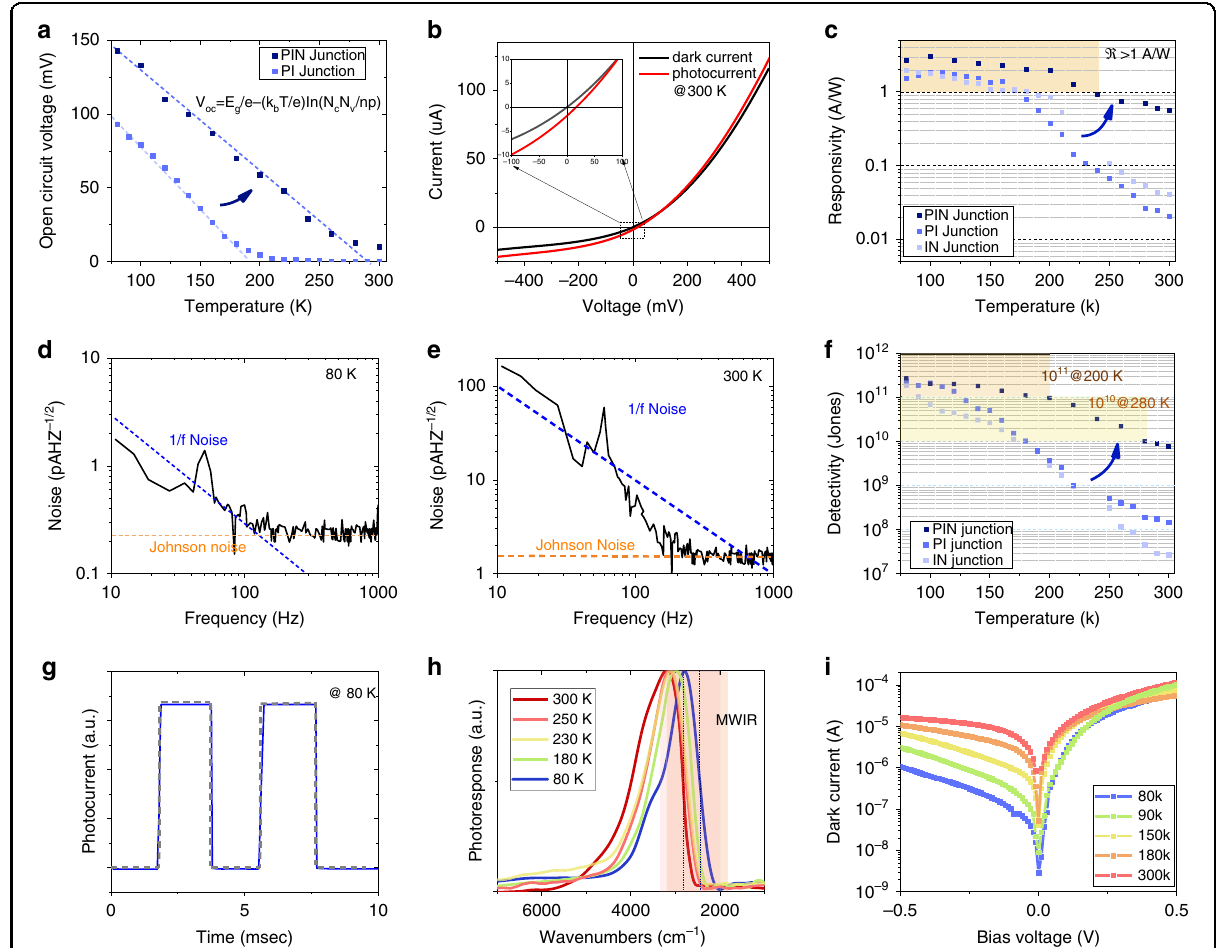
Fig. 3 PV device characterization. a Open circuit voltage as a function of temperature on PIN gradient and PI homojunctions. b IV characterization of PIN gradient homojunction at 300 K. c Responsivity as a function of the temperature of PIN gradient, PI, and IN homojunction devices. d , e Noise spectra of the detector at 80 and 300 K of PIN gradient homojunction devices. f D * as a function of the temperature of PIN gradient, PI, and IN homojunction devices. g Response speed. Photoresponse was measured with the incident light modulated at 500 Hz. h Photoresponse spectra of high mobility homojunction PV at different temperatures. i Dark currents of the PIN junction device vary with